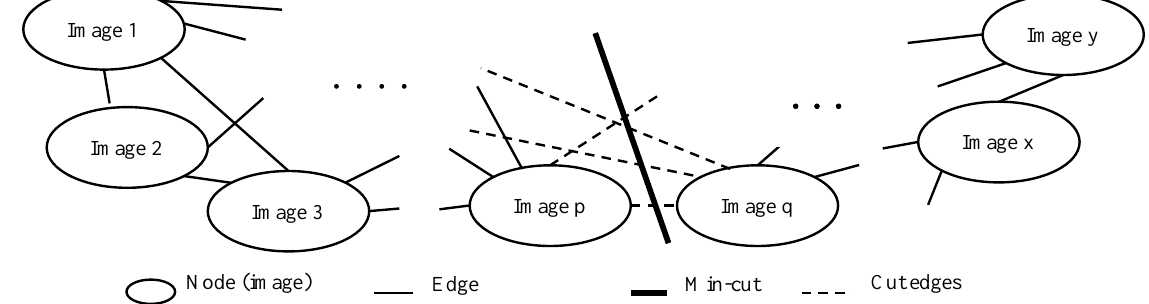
Figure 2. Graph expression of the image relation